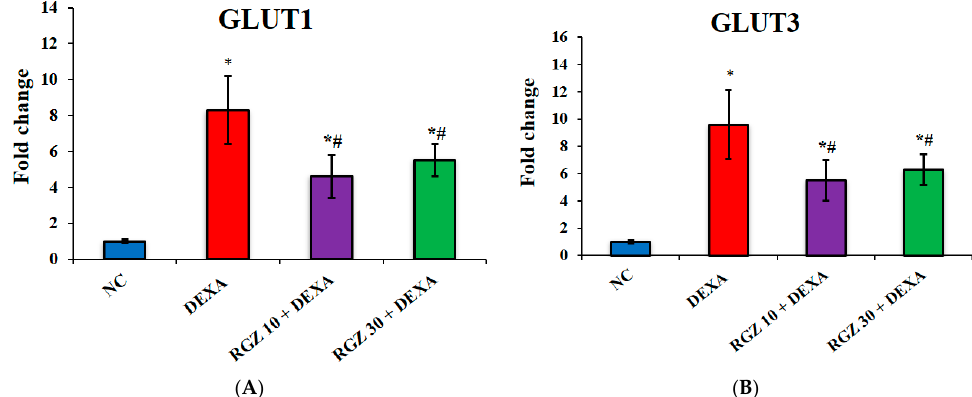
Figure 2. Effect of administration of DEXA, 20 mg/kg; s.c., RGZ, 10 mg/kg, or 30 mg/kg p.o., on GLUT1 ( A ) and GLUT3 ( B ) in the brain of mice. The statistical evaluation was conducted by a one-way ANOVA and then Tukey‘s post hoc test. Values are represented by the mean ± SD ( n = 8). NC—normal control; DEXA—dexamethasone; RGZ—rosiglitazone; GLUT—glucose transporter. A